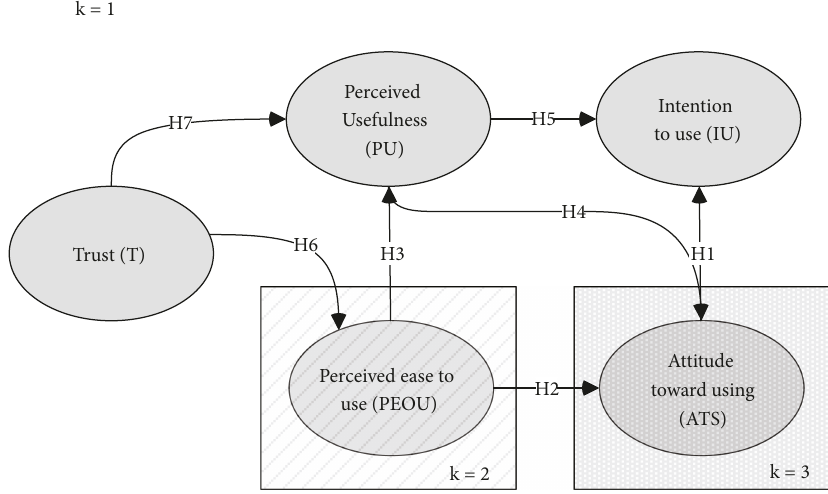
Figure 5: Segmentation